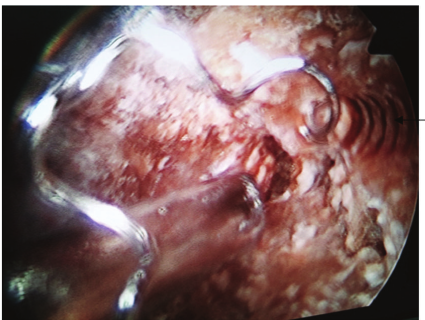
Figure 2: Intraoperative picture showing the renal pelvic stone with themigratedembolizationcoil(arrow).6Fruretericcatheterandthe Amplatz sheath with nephroscope is also